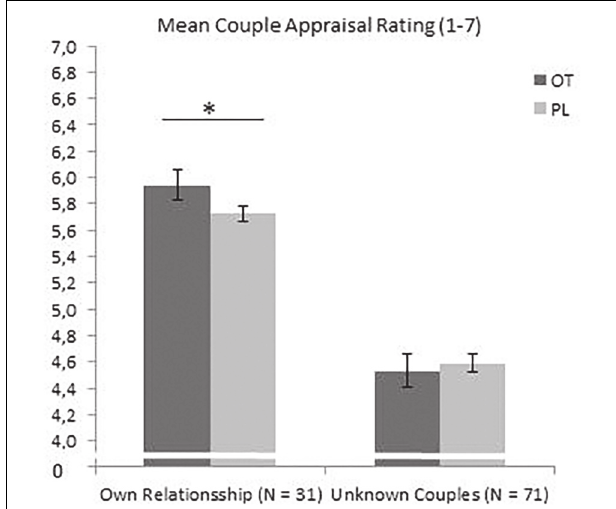
FIGURE 3 | OT increased the CAT ratings toward the own relationship in the subsample of pair-bonded individuals, but not in the whole sample toward the unknown couples. ∗ p <